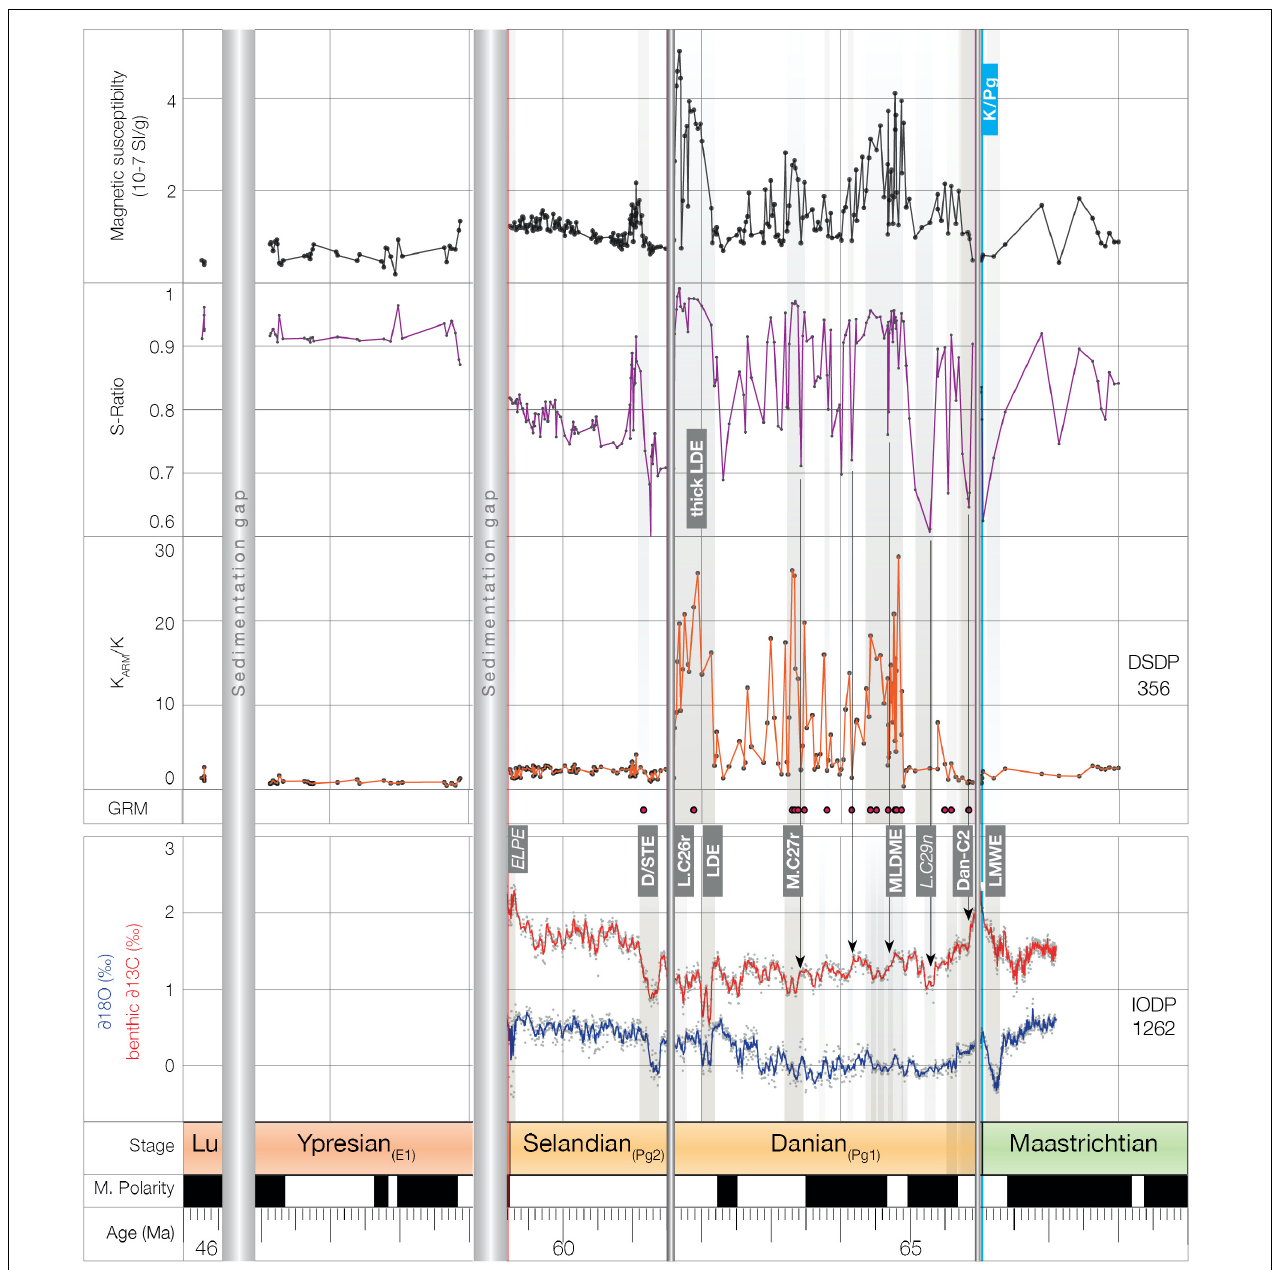
FIGURE 6 | Stratigraphic correlations of Site 356 with global events. From the top: magnetic susceptibility and S-ratio for Deep Sea Drilling Program (DSDP) Site 356 obtained in this study, stage and magnetic polarity, and benthic δ 13 C from Barnet et al. (2019). Marked are the major recognized events reported in the literature discussed in the text: the Cretaceous-Paleogene boundary (blue) and suspected hyperthermal-like events (red): the Cretaceous-Paleogene boundary (K/Pg), the Dan-C2 event (Dinarès-Turell et al., 2014; Jehle et al., 2015), L.C29n (Barnet et al., 2019), M.27Cr (Barnet et al., 2019), Late Danian Events (LDEs) LDE1 and